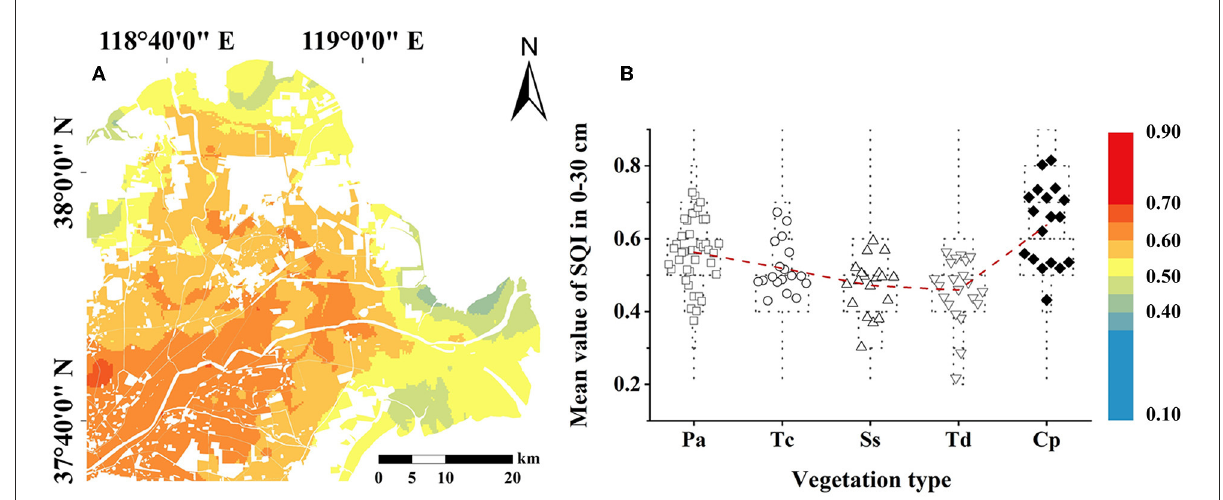
FIGURE4 The mean SQI value of 0–30cm (A) and different vegetation (B) in the Yellow River Delta.